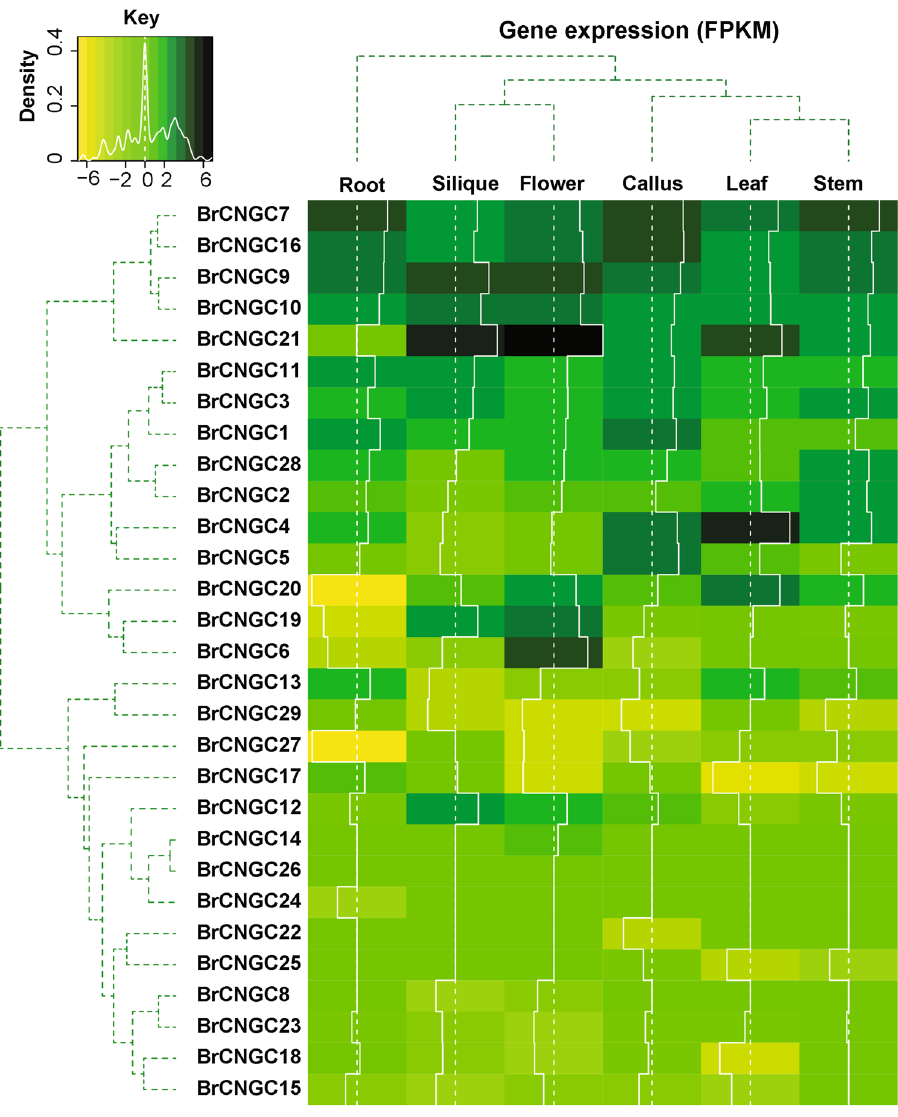
expression (FPKM) is expressed in log2 ratio, with yellow colors indicating lower accumulation of transcripts, and green colors indicating higher accumulation of the gene transcripts. The intensity of transcript abundance is indicated as white histograms within the